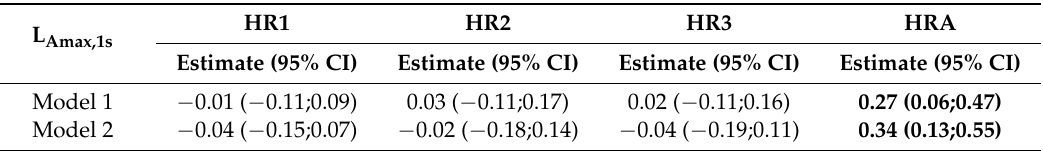
Table 4. Analysis of event-related heart rate